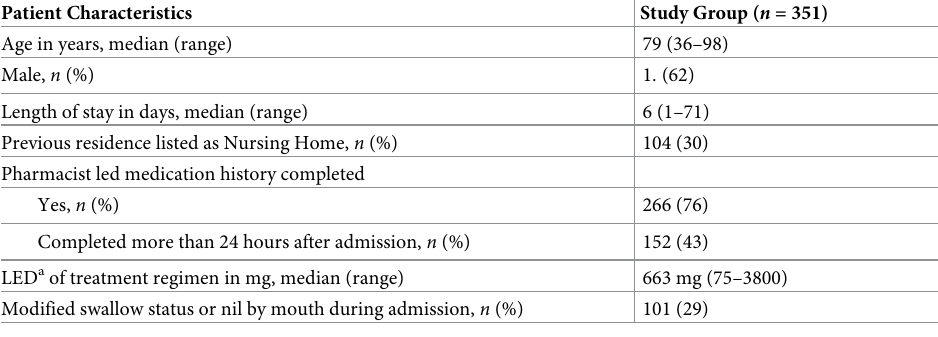
Table 1. Patient characteristics for the people with Parkinson’s disease included in this